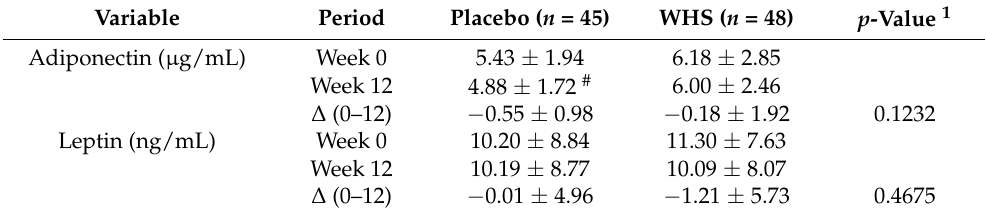
Table 3. Plasma levels of adipokines in